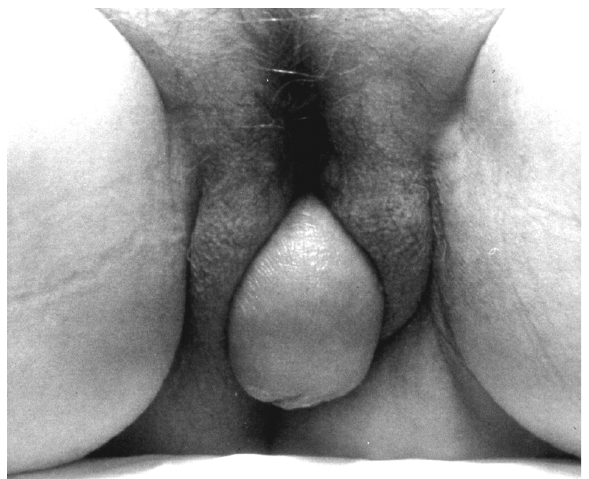
Figure 1 – Marked vaginal prolapse throughout its entire extension.